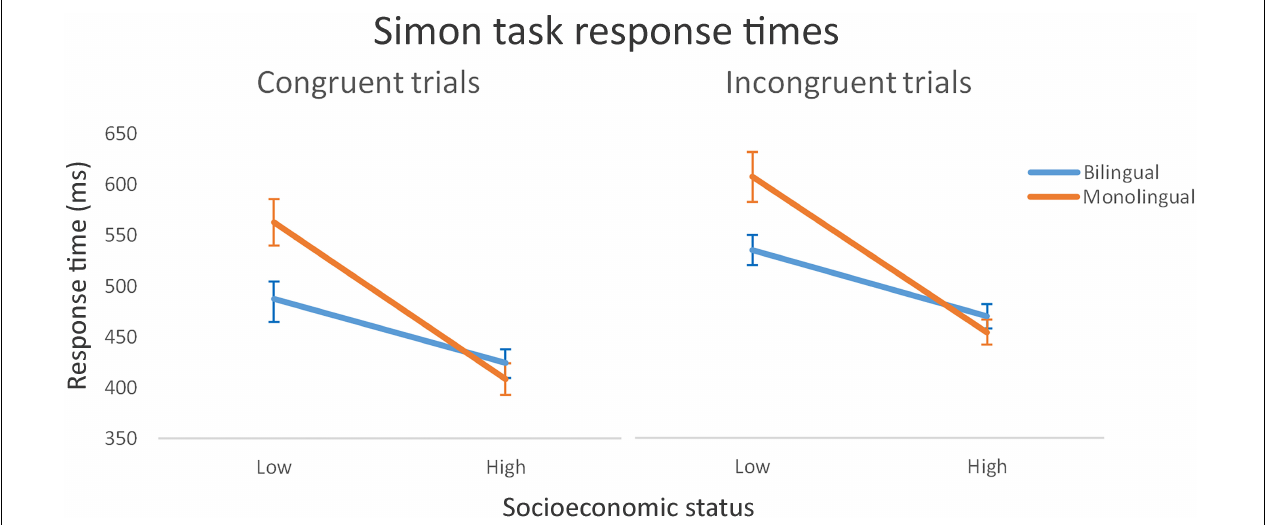
FIGURE 1 | Mean Simon task response times (with standard error bars) for congruent and incongruent trials by group (bilinguals/monolinguals) and socioeconomic status (low/high).